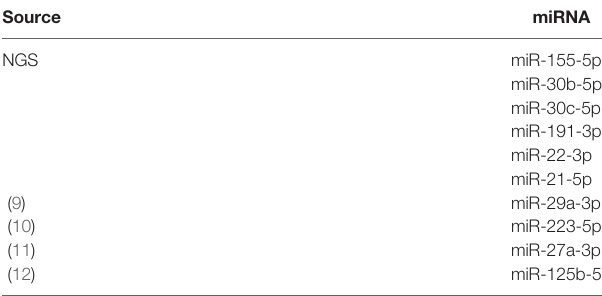
FinalselectionofmiRNAcandidatesforongoingmechanisticanalyses.6miRNAsthatmet selection criteria were selected from 20 miRNAs differentially expressed in more than one “ top3 ” condition.4additionalliterature-identi fi edcandidateswereselectedbasedontheir representation in previously published relevant